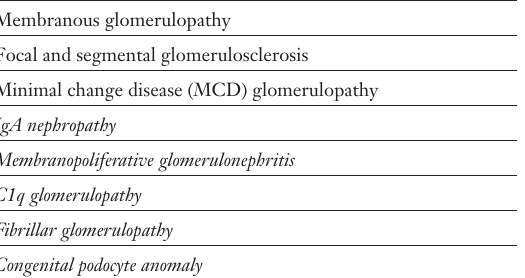
Primary glomerular diseases associated with nephrotic